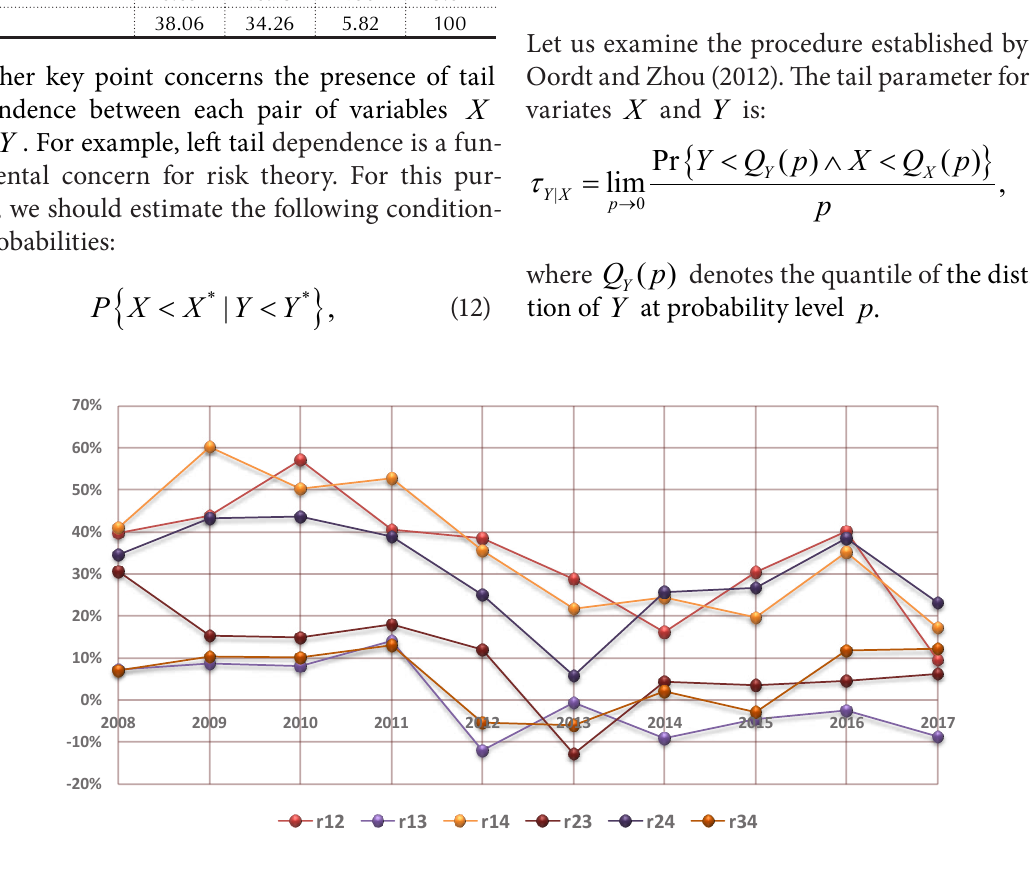
Figure 2. Linear correlation coefficients between each pair of returns variables: MIB (1), oil (2), gas (3) and coal